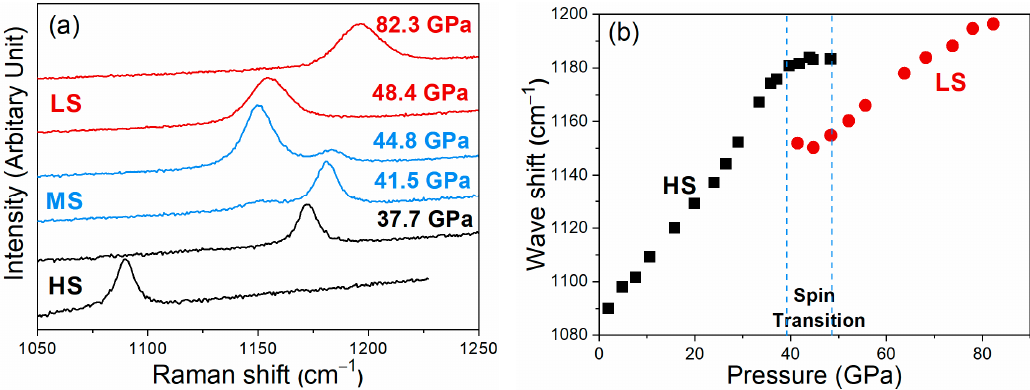
Figure 2. Representative Raman spectra ( a ) and Raman shifts ( b ) of ν 1 mode of siderite using NaCl as a pressure-transmitting medium. A weak shoulder assigned as the ν 1 ′ mode near the initial ν 1 mode was observed between 38 and 48 GPa. The ν 1 and ν 1 ′ modes correspond to the high- and low-spin (HS and LS) states, respectively. The obvious split of ν 1 mode at 41.5 and 44.8 GPa represents the mixture spin state of siderite. With the further increase of pressure, the intensity of two ν 1 modes is exchanged. The ν 1 mode completely disappears at 48.4 GPa, indicating the completion of spin transition. The two blue dashed lines represent the spin crossover of siderite.